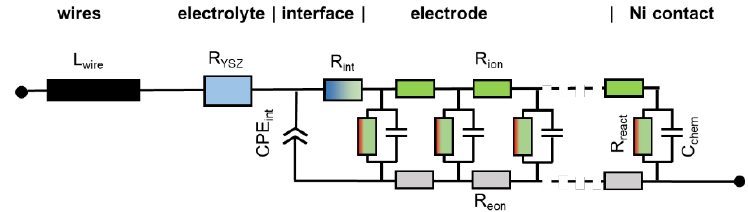
Figure 3. Circuit model used for fitting the impedance spectra, which includes elements that model the electrolyte ohmic resistance, wiring inductance and ion conduction through the electrode- electrolyte